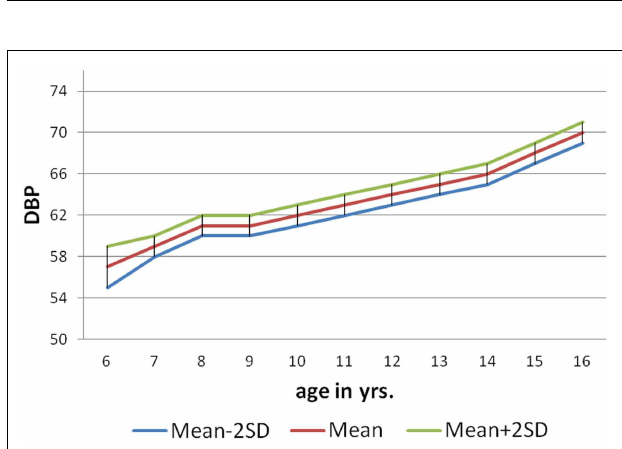
FIGURE 3 | Norms of mean SBP according to age in girls (6–16years) .